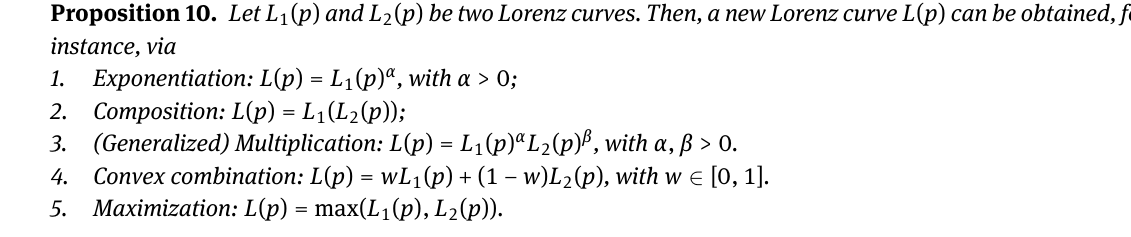
term alchemy is used by Sarabia and Arnold to indicate a set of techniques for generating new Lorenz curves starting from given ones. Some relevant cases are presented in the following proposition, for the proof of which see